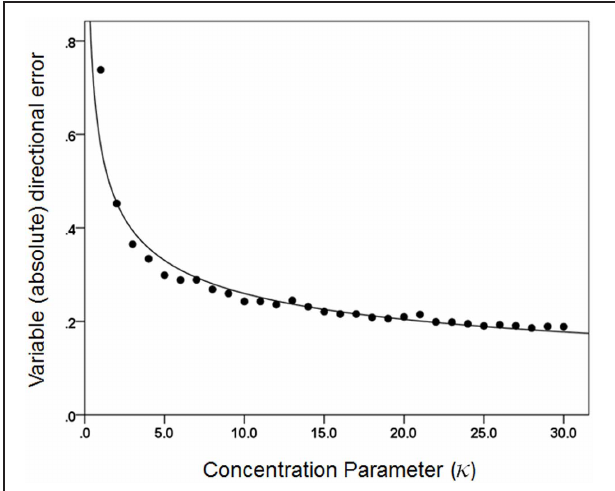
FIGURE 1 | Plot of 30 directional tuning curves generated using Equation 1 (see text), one for each one of 30 κ values {1, 2, 3, ... , 28, 29, 30}. Each curve is standardized to its maximum.